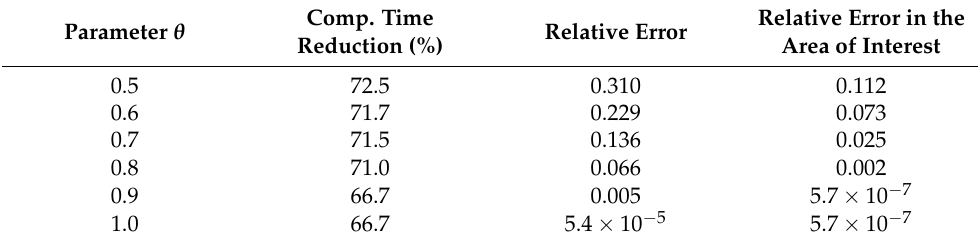
Table 3. Performance indicators for the fourth